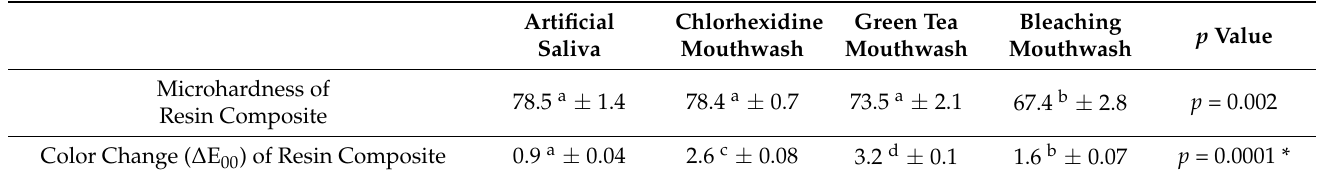
Table 3. The pH of artificial saliva and different mouthwashes.